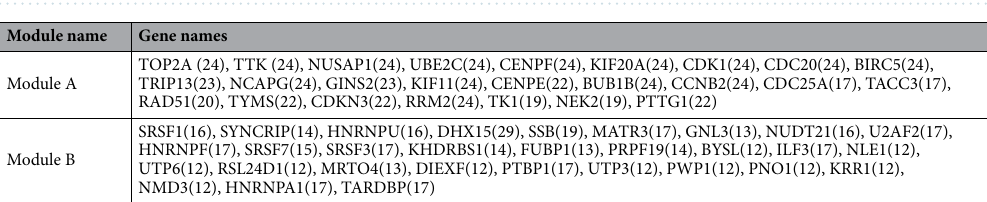
Table 1. Gene names of modules A and B. Numbers inside the parentheses represent the genes